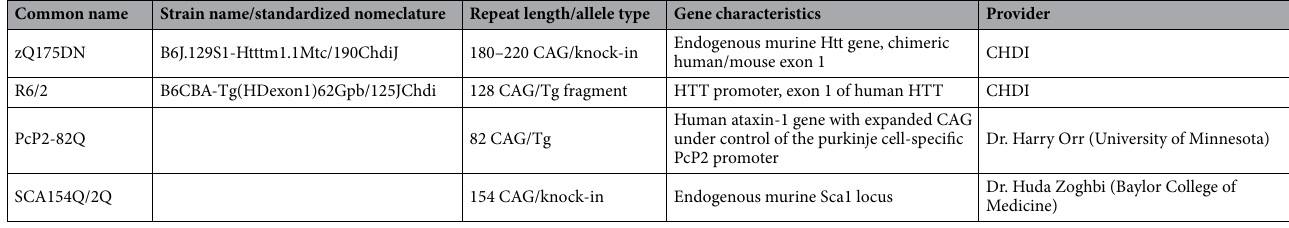
Table 2. Mouse strain